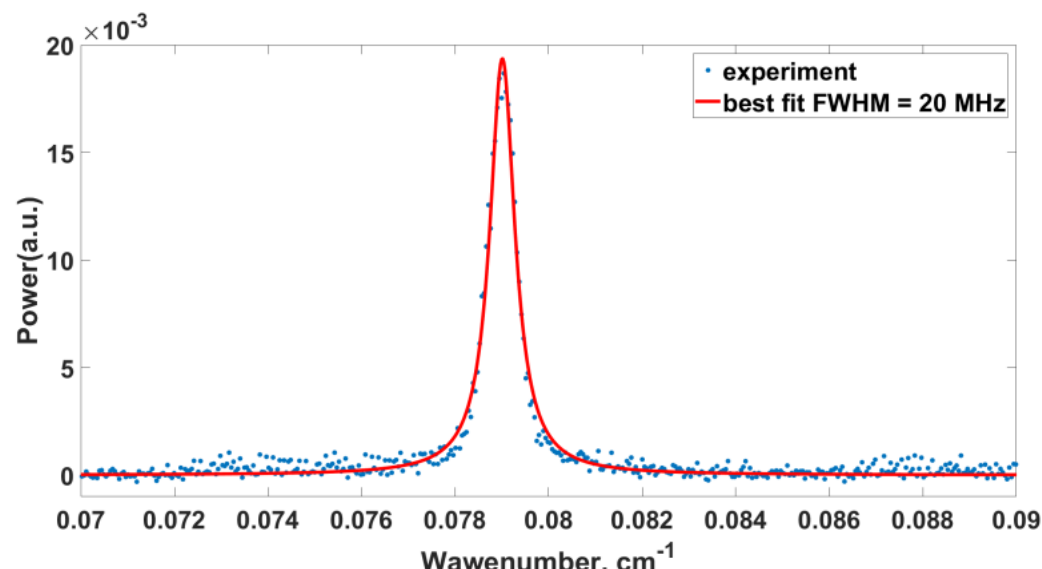
Figure 2. To the spectral resolution of the ground-based prototype of the multichannel laser heterodyne spectroradiometer (MLHS). Beat signal (blue dots) and the Lorentzian fit with FWHM of 20 MHz (red curve) provides a spectral resolution of the instrument about 0.0013 cm −1 .